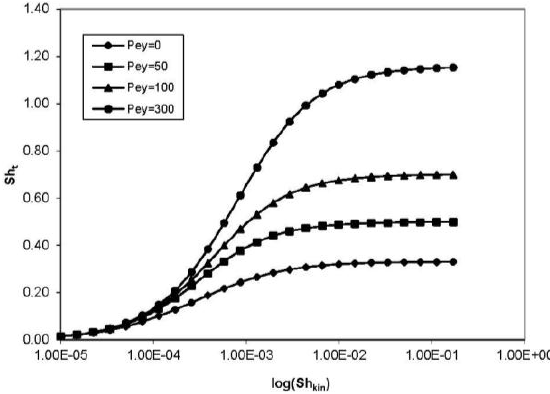
Figure 8. Effect of the electrochemical kinetics. For each Pe y the reduced total flux at the electrode Sh t ranges from zero to the maximum value Sh M (limit current). (B/D = 1; H/D = 0.1; x A1 = x A2 ; Pe y ranges from 0 to 300).